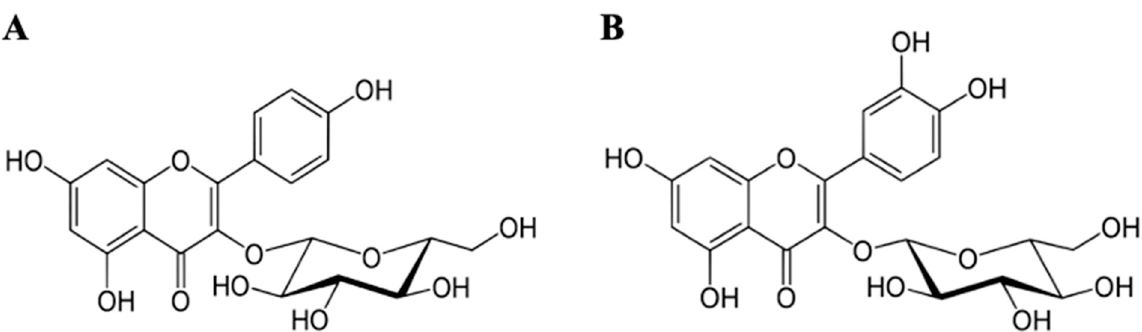
Figure 1. Structures of ( A ) astragalin (Ast) and ( B ) isoquercitrin